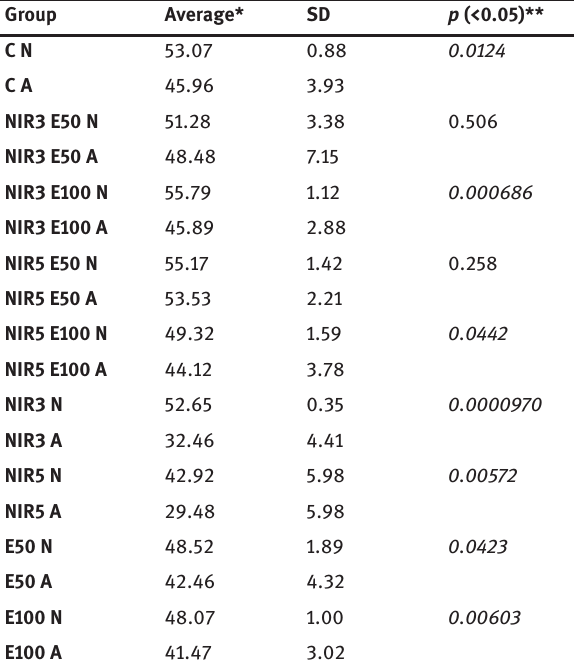
Table 5: Comparison of chlorophyll content between normal (N) and abnormal (A) soybean seedlings in each group (SPAD